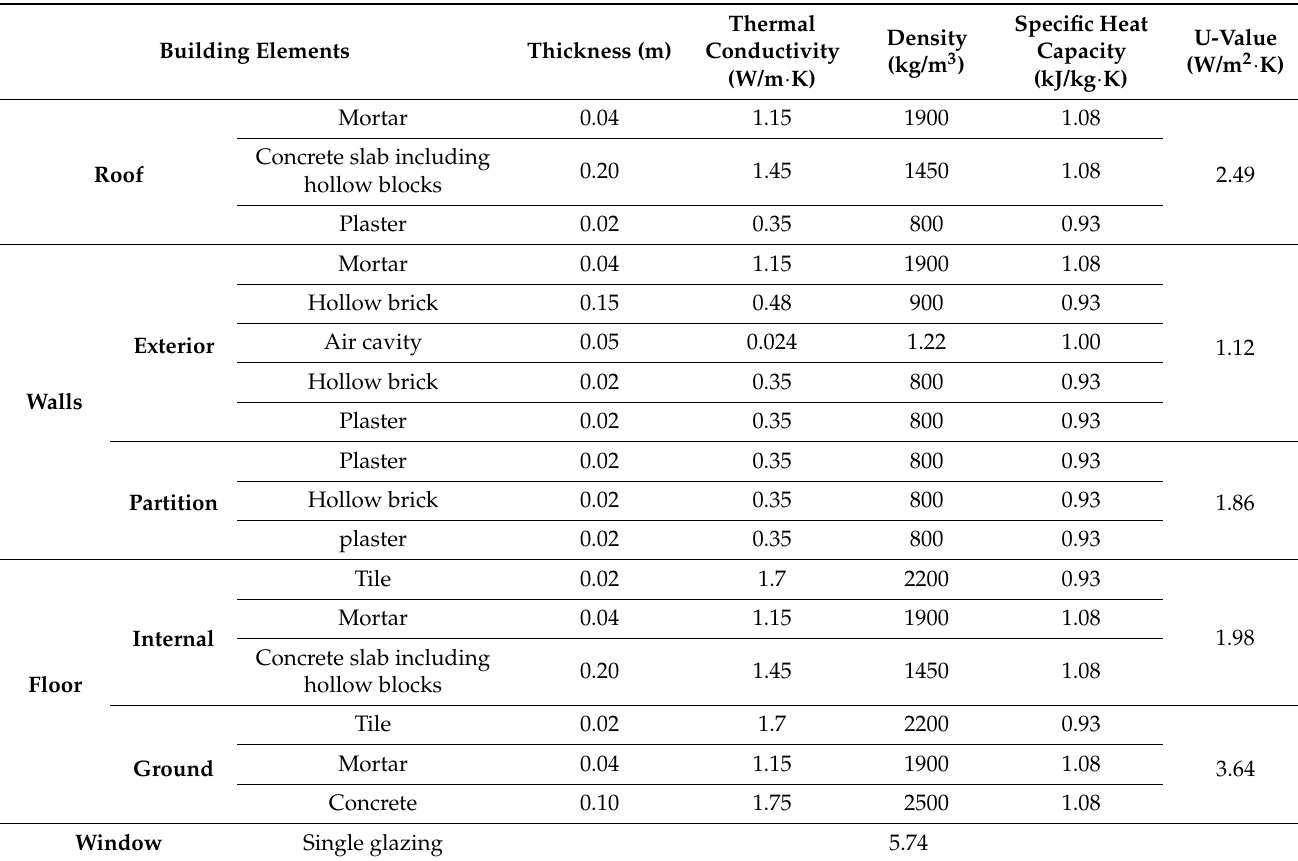
Table 1. Thermo-physical properties of the materials used in the construction components of the base case building.